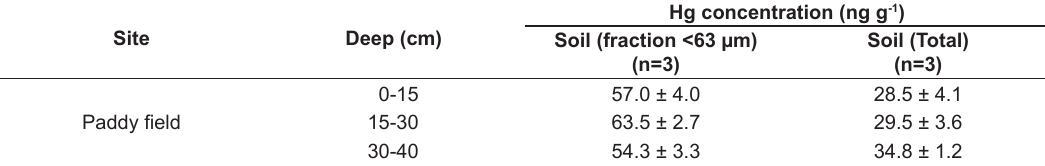
Table 1. Mercury concentration (ng g -1 ) in soils from the study area.